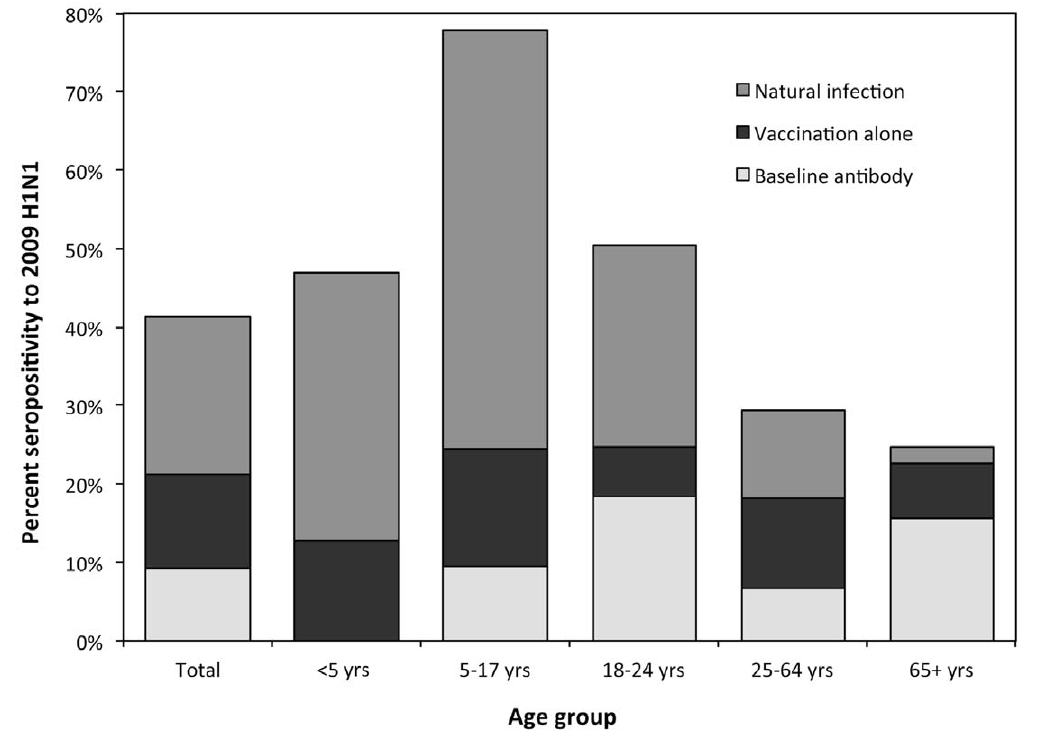
Figure 4. Estimated seroprevalence to A(H1N1)pdm09 through December 2009 by source and age group, adjusted for the sensitivity and specificity of HI assay.